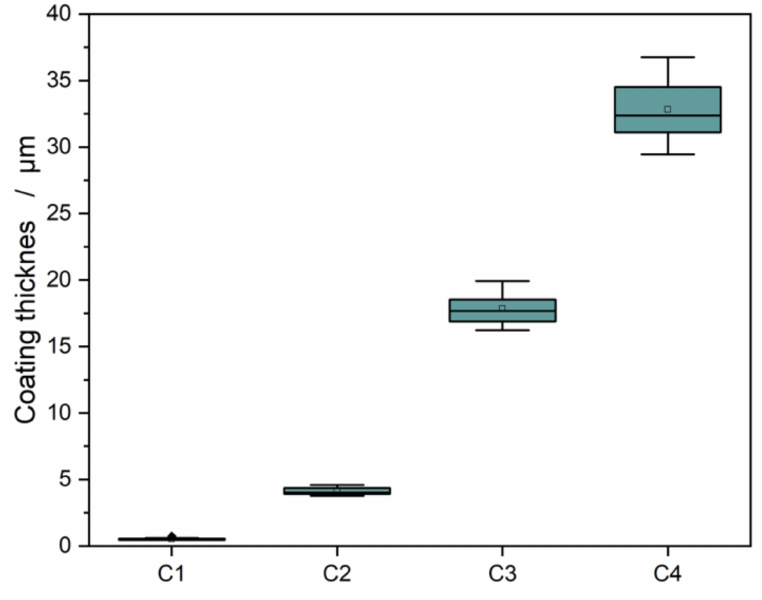
Figure 1. Coating thickness of the four different parylene